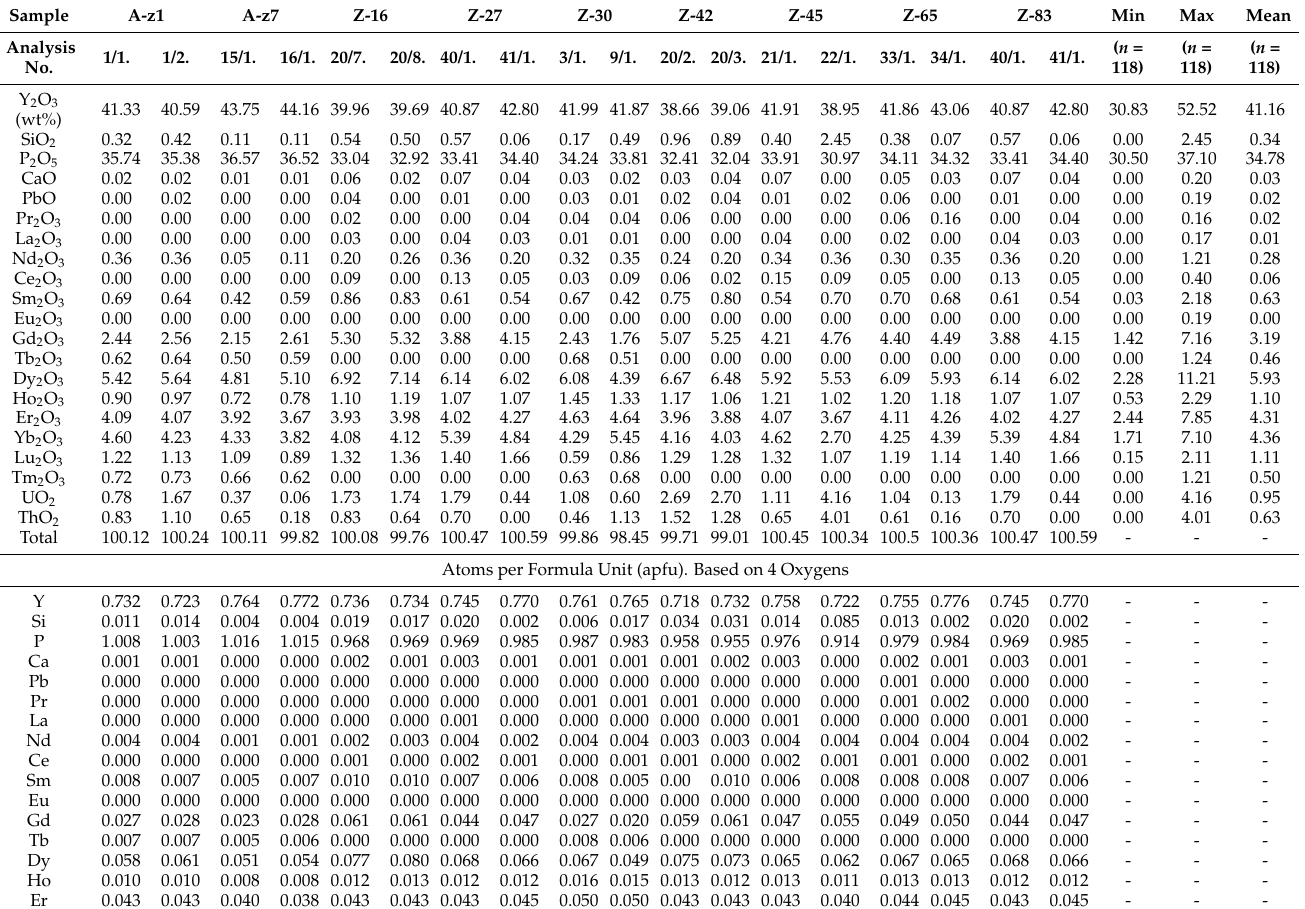
Figure 6. Ternary plots of analyses. ( A ) LREE-HREE-Y; ( B ) LREE-Th + U-HREE + Y in xenotime. Table 4. Chemical composition of xenotime with heterogeneous internal structure. EMP